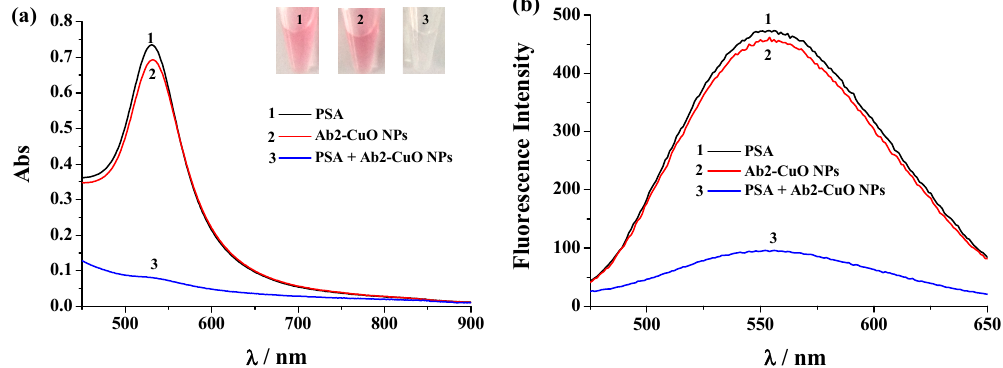
Figure 3. The UV-Vis absorption spectra and photographic images (the inset) ( a ) and emission spectra ( b ) for different detection systems. Curve or tube 1, prostate-specific antigen (PSA); curve 2 or tube 2, Ab2-CuO NPs, PSA; curve 3 or tube 3, PSA + Ab2-CuO NPs. The final concentration of PSA was 50 ng/mL.